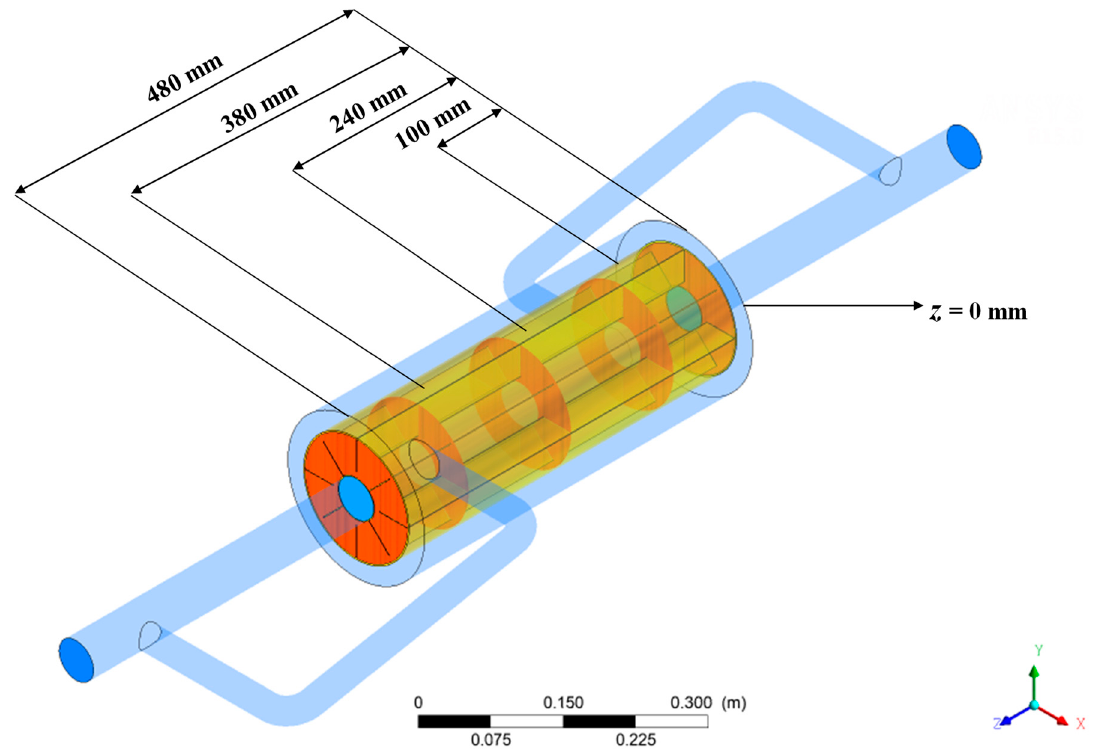
Figure 4. Isometric and frontal views of the fluid domain of the CHTF: inner and intermediate tubes.